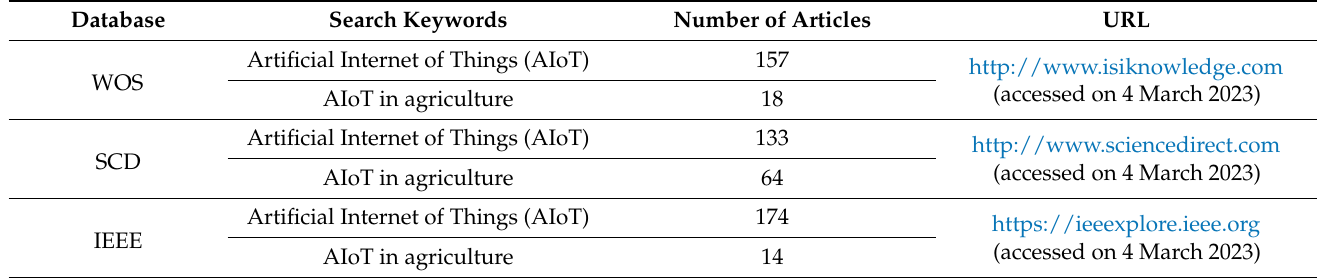
Table 2. The details for database search